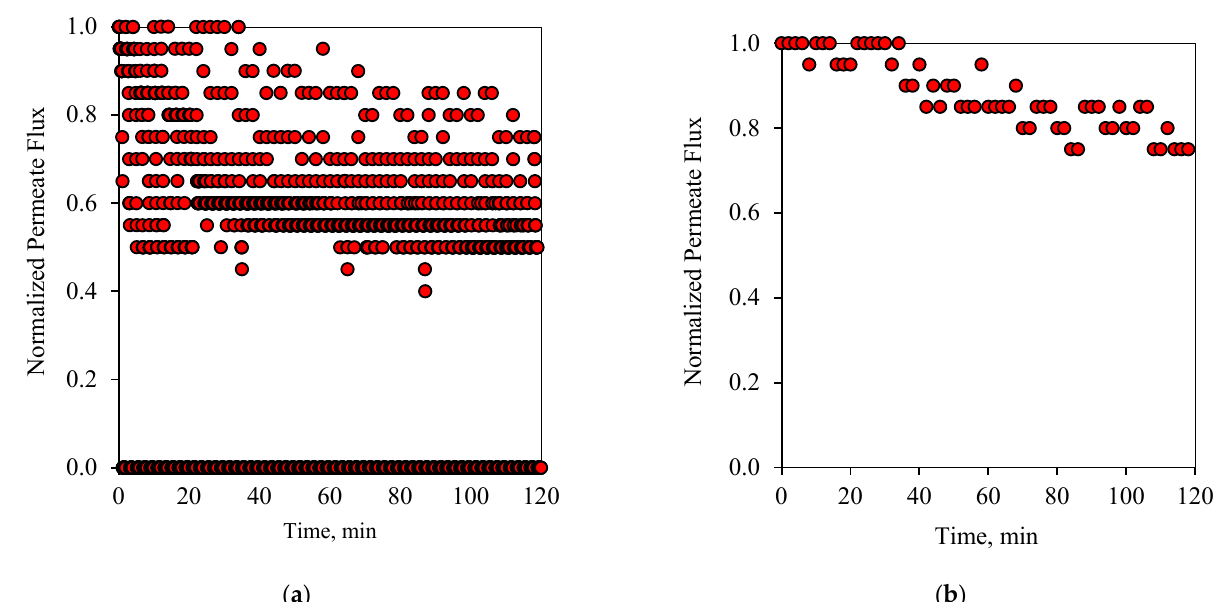
Figure 7. Permeate flux profile using the 1-1 PFPT for a feed of 200 ppm at CFV: 1 m/s: ( a ) PFPT filtration mode, ( b ) membrane permeability after each cleaning half-cycle.